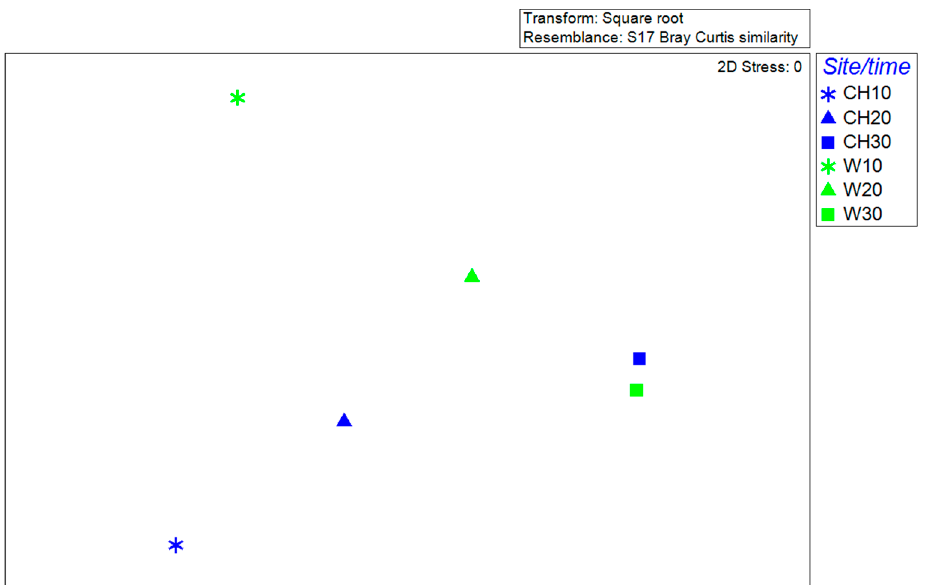
Figure 4. Non-metric multidimensional (nMDS) plot of bacterial communities. Each of CH10, CH20, CH30, indicates samples collected in Chilbolton at high elevation (range of 950–1000 m asl) in the time duration of 10 min, 20 min, and 30 min. Each of W10, W20, W30, indicates samples collected in Weybourne (height range of 650–1000 m) in the time duration of 10 min, 20 min, and 30